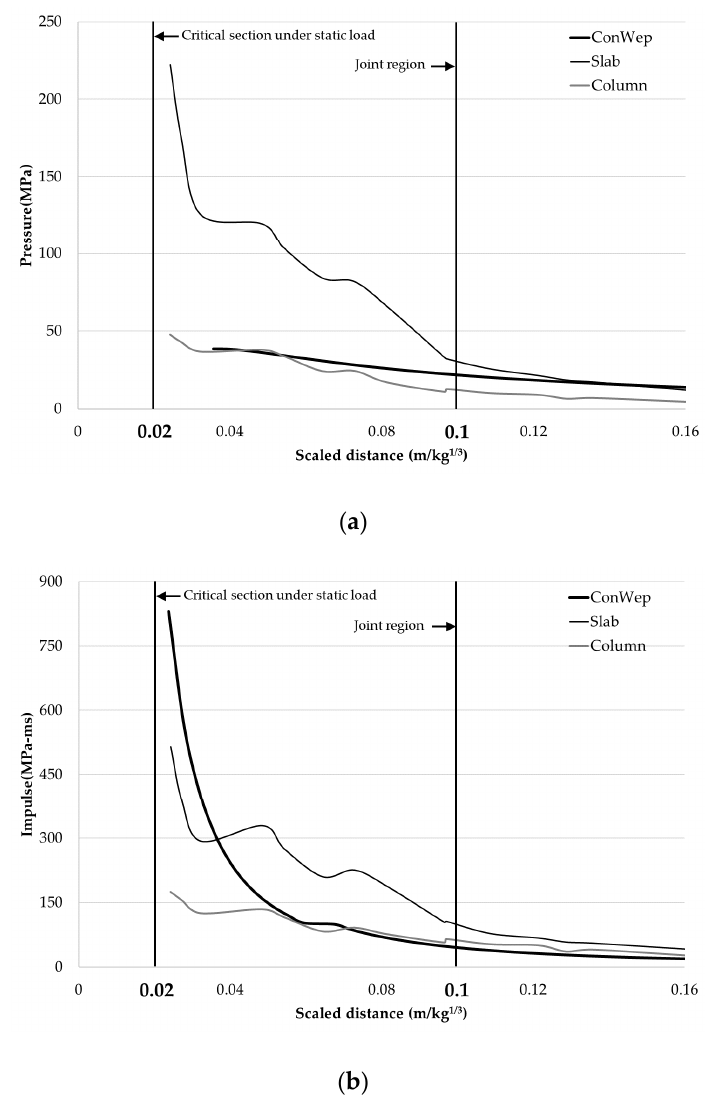
Figure 2. Defining joint region under blast load; ( a ) Pressure; ( b ) Impulse.